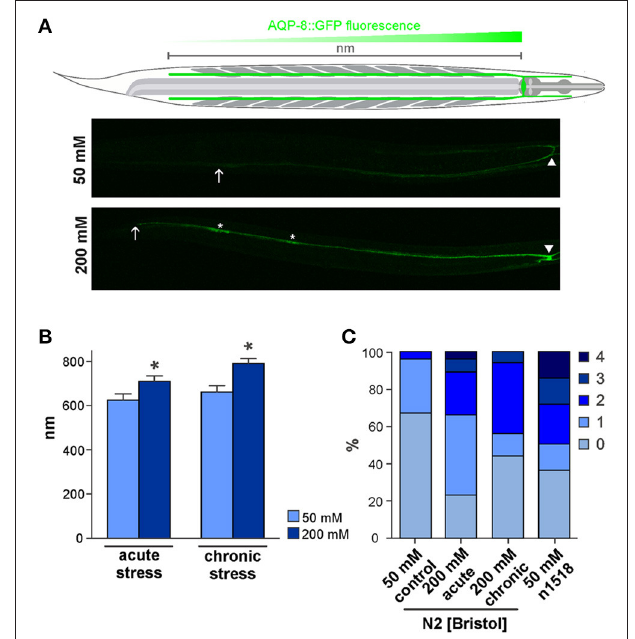
FIGURE 2 | AQP-8 protein expression throughout the excretory canal and aqp-8 isoform analysis. (A) Schema of the C. elegans and the excretory cell. Example of the AKR-14 + / + ; aqp-8 ::GFP expression in the posterior excretory canal under control and chronic stress conditions. The arrows indicate the maximum spreading of the signal, starting from cell soma (arrow head) throughout to the posterior canal (arrow). Varicosities are marked by asterisk. (B) Analysis of the AKR-14 + / + ; aqp-8 ::GFP fluorescence pattern after 8h acute and chronic 200mM NaCl stress conditions in the excretory cell compared to 50mM NaCl control conditions. The spreading of the GFP signal from the cell soma throughout the posterior excretory canal was measured and plotted. Student’s t -tests were performed relative to control conditions; N > 16 (* p < 0.05). (C) Number of varicosities visible in one posterior excretory canal per animal. The number of canals with varicosities is significantly lower under control conditions compared to acute ( p = 0.0008) and chronic ( p = 0.0070) stress conditions. There are significantly more varicosities in an osm-8(n1518) ( p = 0.0007) background compared to wild type animals even under isotonic conditions, as determined by Students t -test. N >